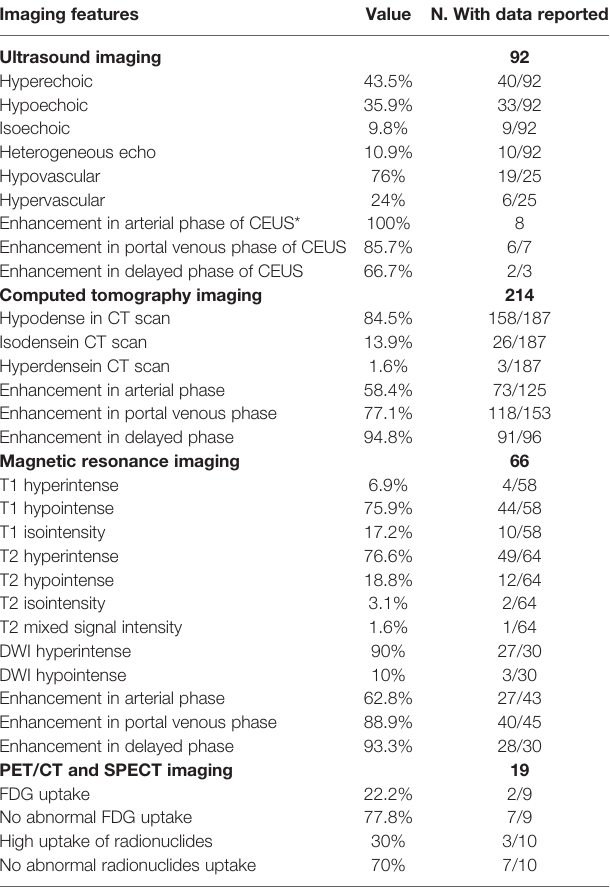
*CEUS, Contrast-enhance Ultrasound. Bold letters represent different types of imaging examination and are a summary of the total number of published cases with imaging fi